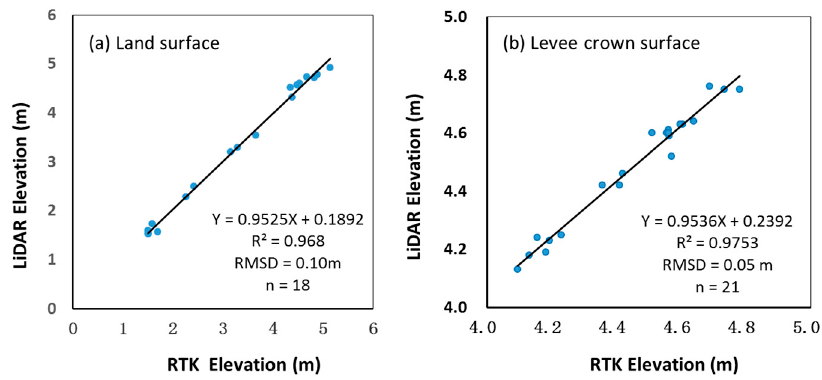
Figure 6. Comparison of ground measured elevation using GNSS RTK and the airborne LiDAR for ( a ) the original 0.5 m grid DEM on land surface and ( b ) the levee crown height extracted from the 0.5 m DEM by the script.